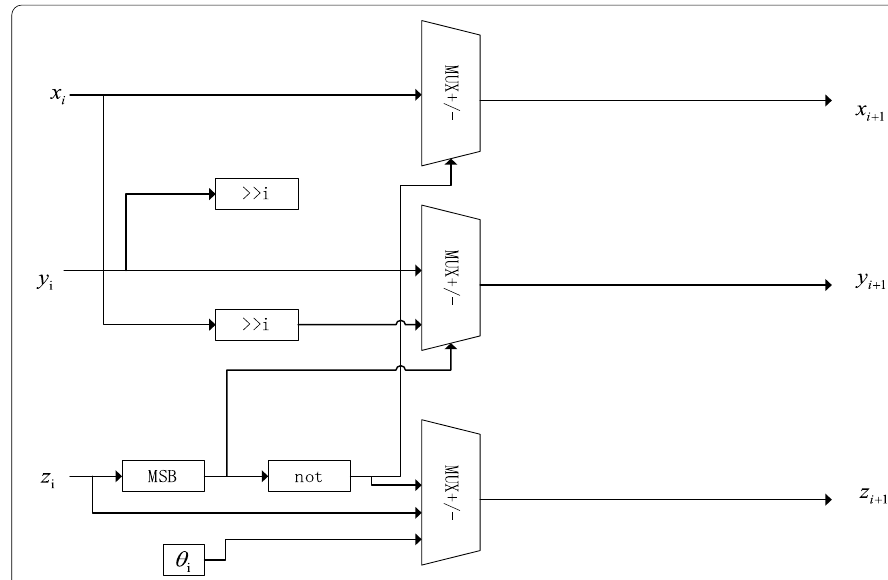
Fig. 5 CORDIC iteration module hardware architecture